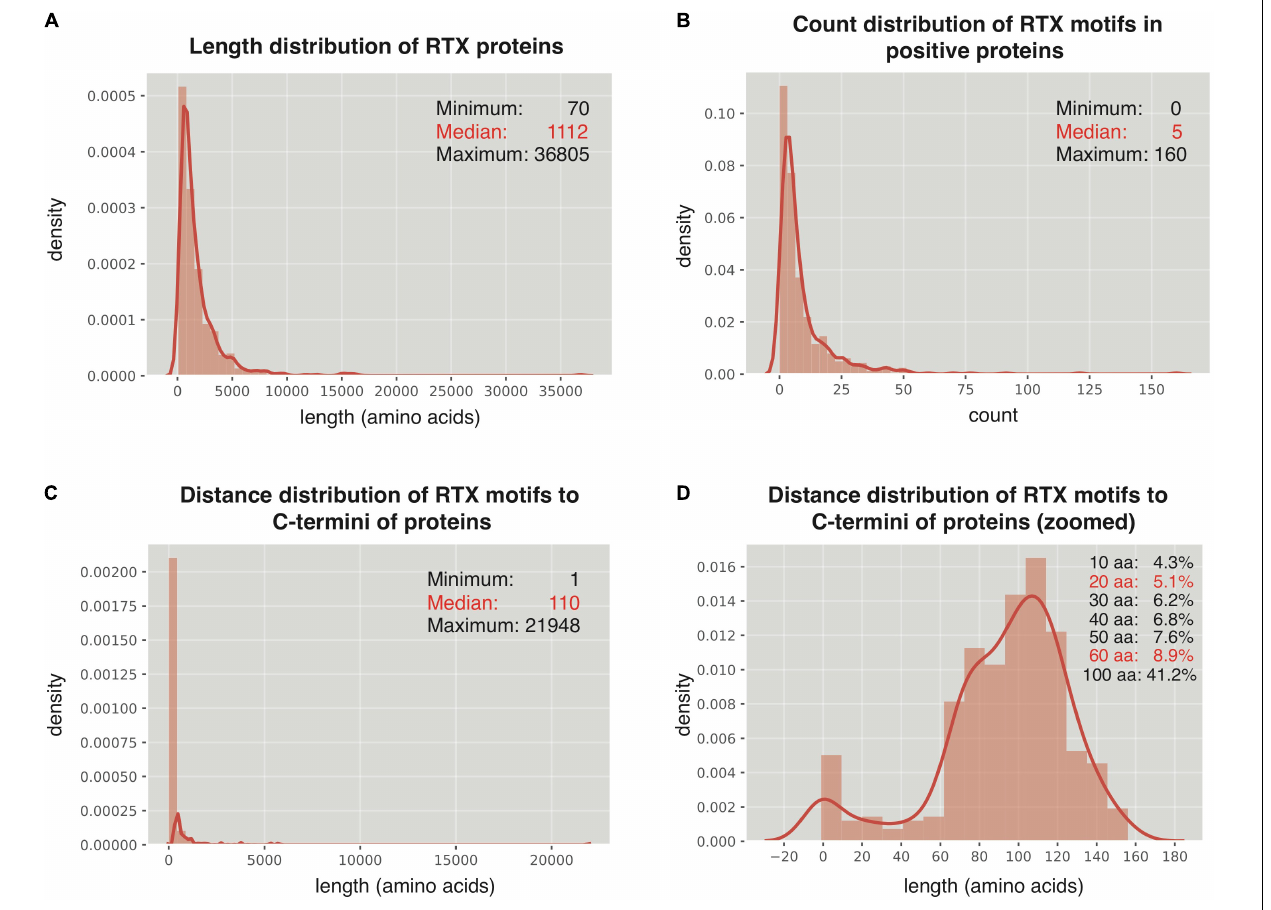
FIGURE 2 | Distribution of RTX motifs in RTX proteins. (A) Length distribution of the RTX proteins. (B) Count distribution of RTX motifs in the RTX proteins. (C,D) Distance distribution of RTX motifs to the C-terminal ends of the RTX proteins. The accumulated probabilities of the proteins with the RTX motif distance of ≤ 10 ∼ 60-aa and 100-aa from the C termini are shown in (D)